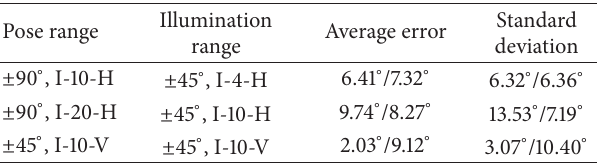
Table 4: Estimation accuracy by computing the relative horizontal angles for different flashes. Camera numbers are 5, 27, and 34.